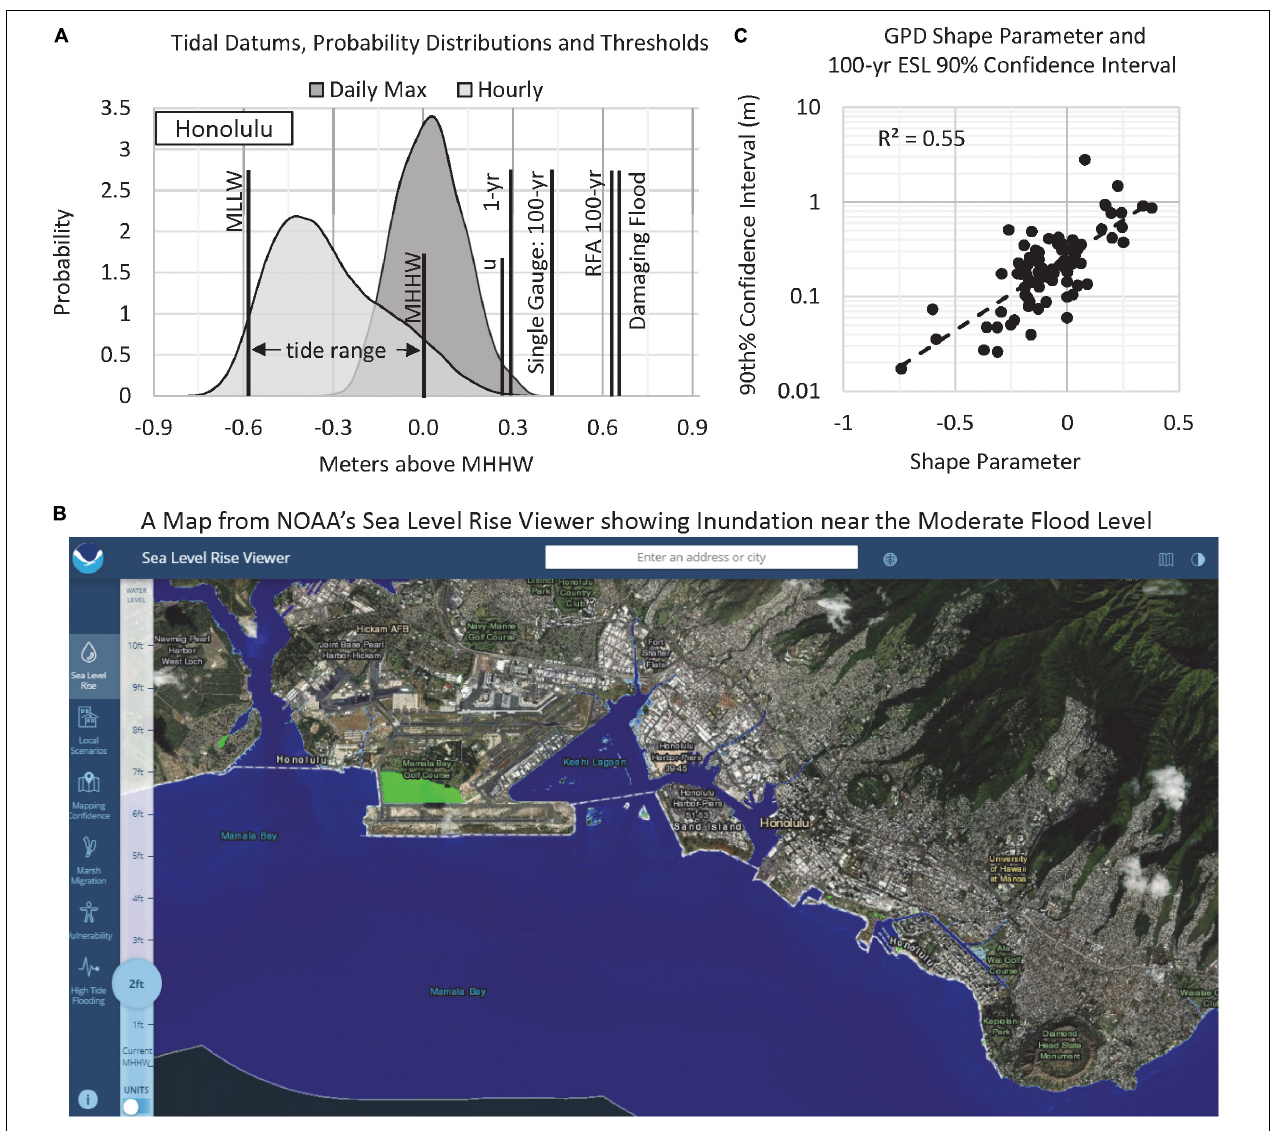
FIGURE 1 | (A) Empirical probability distributions of hourly and daily highest water levels at the NOAA TG in Honolulu with tidal datums [mean lower low water (MLLW), mean higher high water (MHHW) and tide range], the 1- and 100-year extreme sea level probabilities and a proposed Pacific damaging flood threshold for Honolulu. In (B) is a map from NOAA’s Sea Level Rise Viewer for Honolulu (https://coast.noaa.gov/slr/#/layer/slr) showing 0.6 m (2 feet) of inundation that is slightly below the damaging flood level. In (C) is the GPD shape parameter values based upon a single TG analysis from this study and the spread of the 90% confidence interval from all TGs with an exponential fit. Positive shape parameters generally occur where extreme outliers (e.g., tropical storm surges) tend to